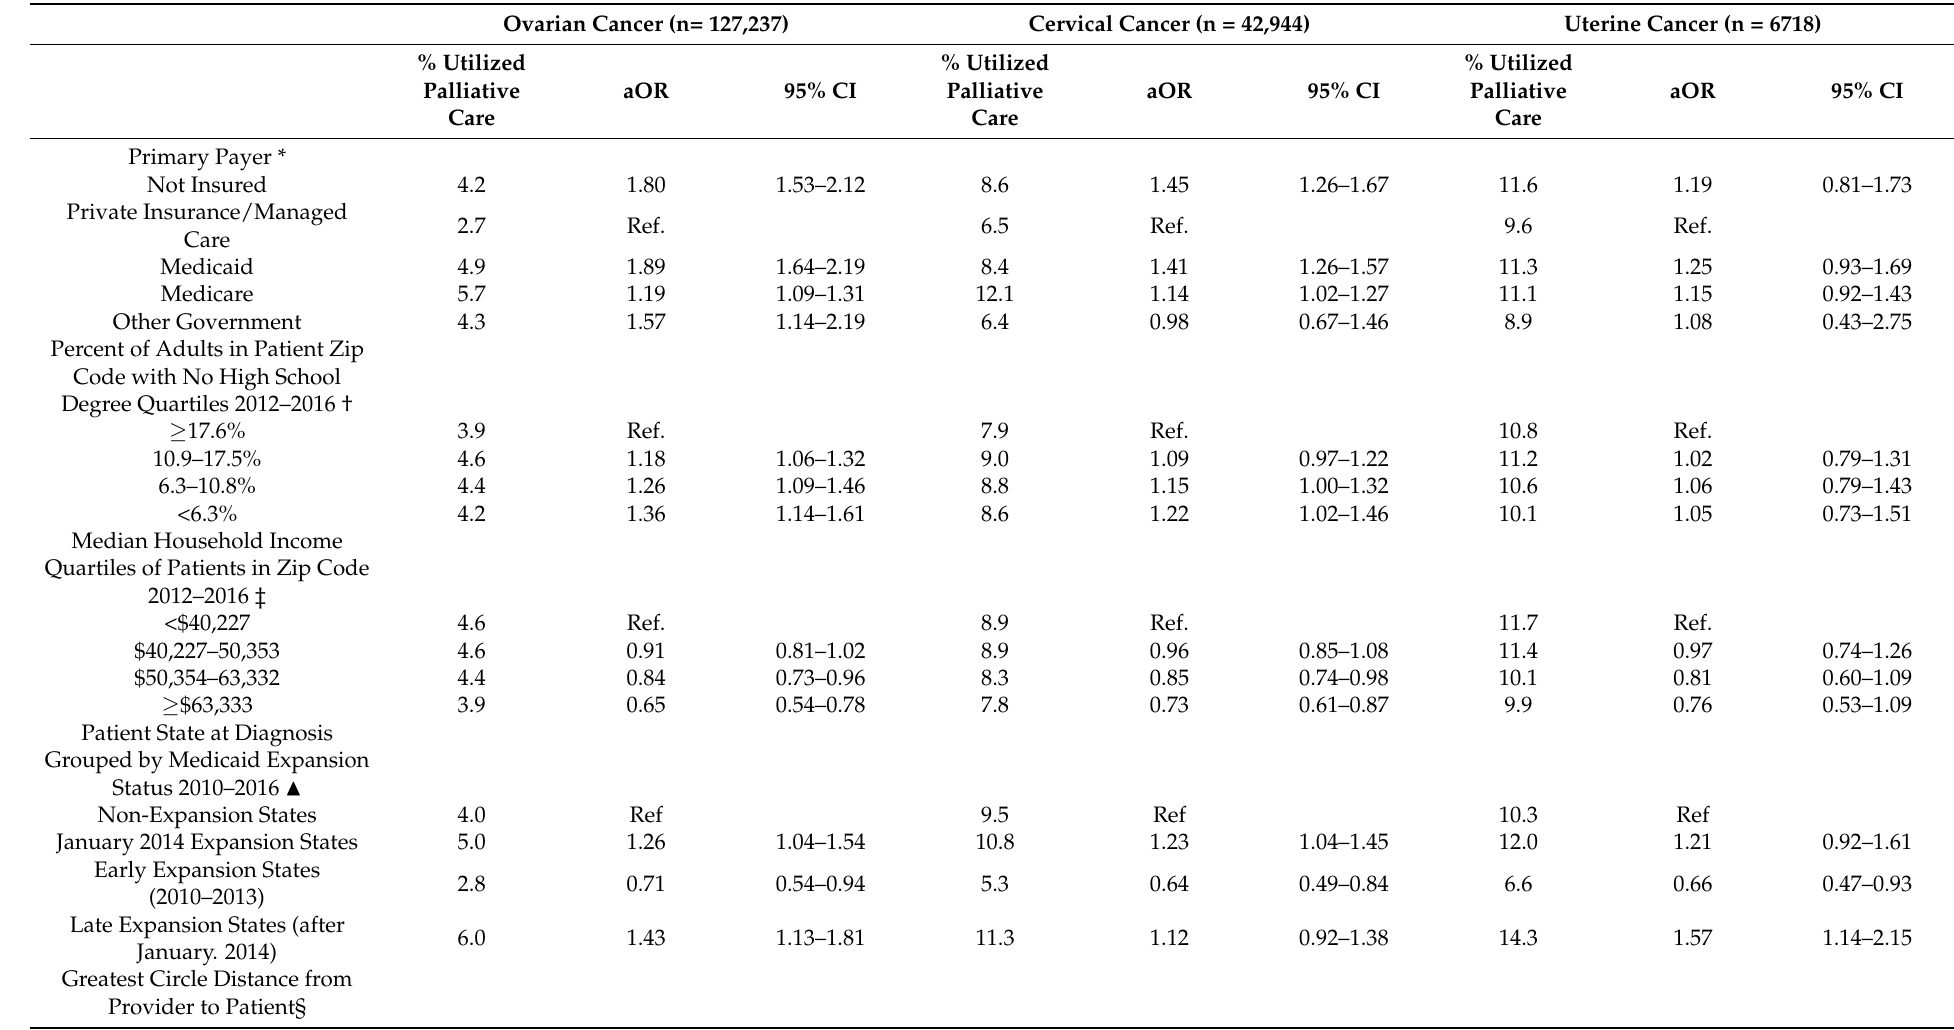
Table 3. Associations of Health Care Access Factors with Palliative Care Use Among All Metastatic Gynecological Cancer Patients by Cancer Site (n =